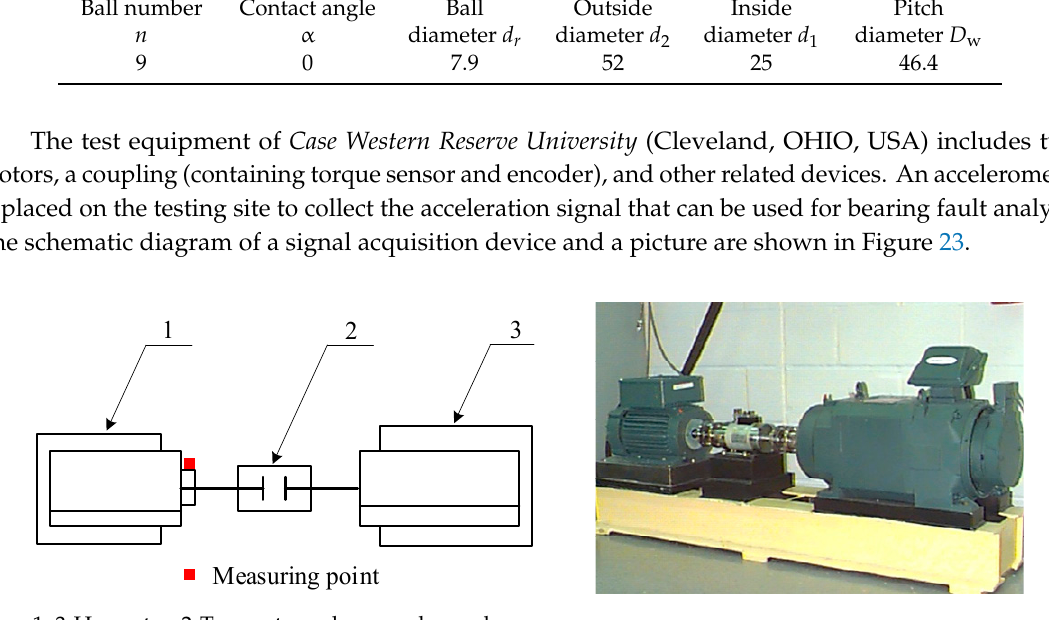
Figure 23. The schematic diagram and a picture of the device.